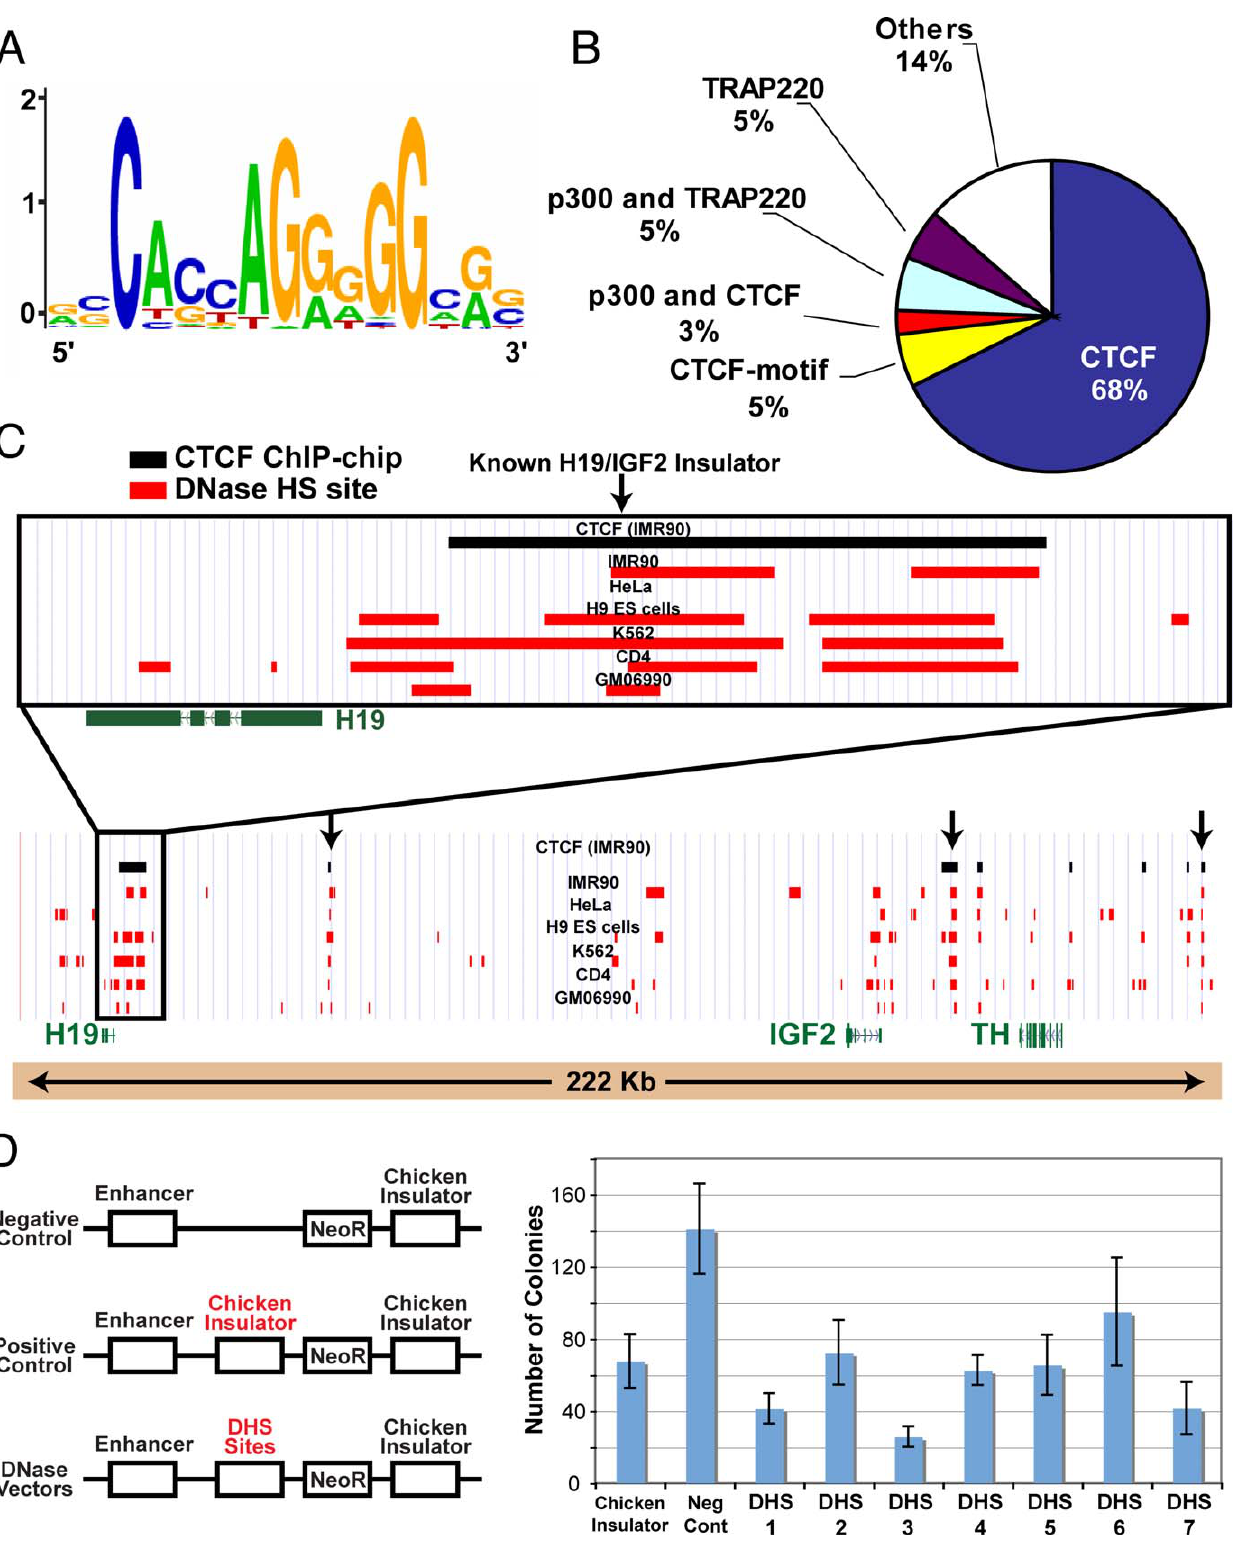
Figure 4. The CTCF Motif Is Identified in Ubiquitous Distal DNaseI HS Sites (A) Motif identified using de novo motif-finding algorithm using the minimal intersecting regions of ubiquitous distal DNaseI HS sites. The overall height of the stack of letters in a position indicates the sequence conservation at that position, while the height of letters within the stack indicates the relative frequency of each base at that position . (B) Percentage of ubiquitous distal DNaseI HS sites that overlap with CTCF ChIP-chip data, CTCF motif, or other enhancer elements. (C) Example of clustered ubiquitous DNaseI HS sites that overlap CTCF in the H19/IGF2 locus. Arrows indicate ubiquitous DNaseI HS sites overlapping with CTCF. PLoS Genetics |